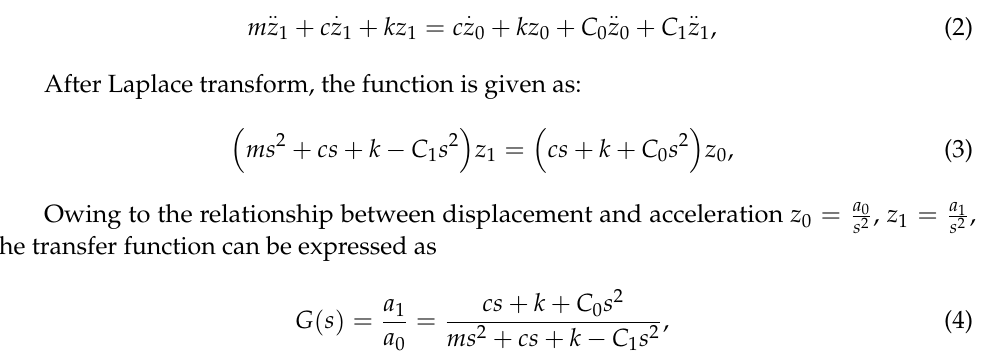
Figure 3. Control block diagram of the AVIS.